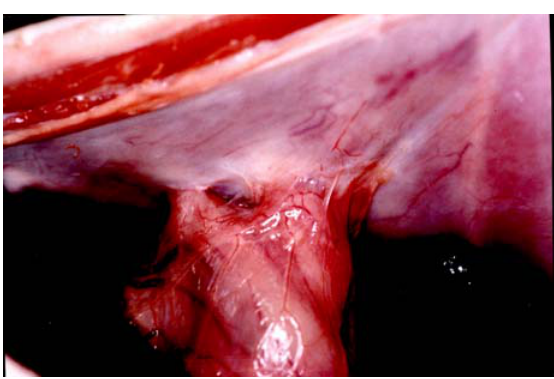
FIGURE 15 - Laparotomy shows the gastrostomy externally.